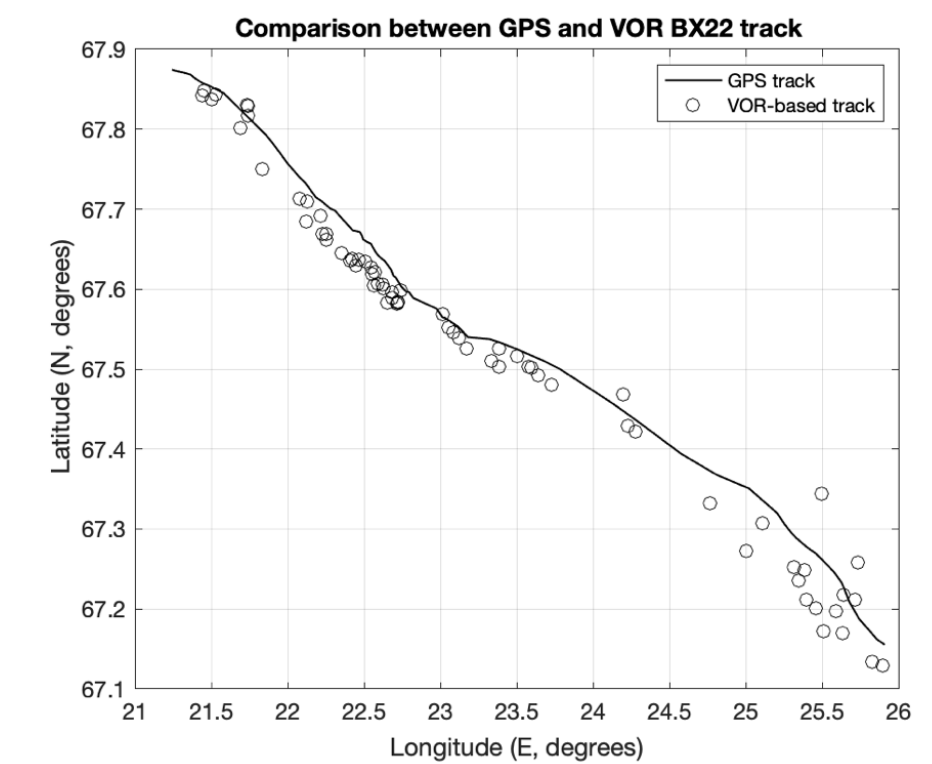
Figure 1. Comparison between GPS and VOR-based balloon ground track.